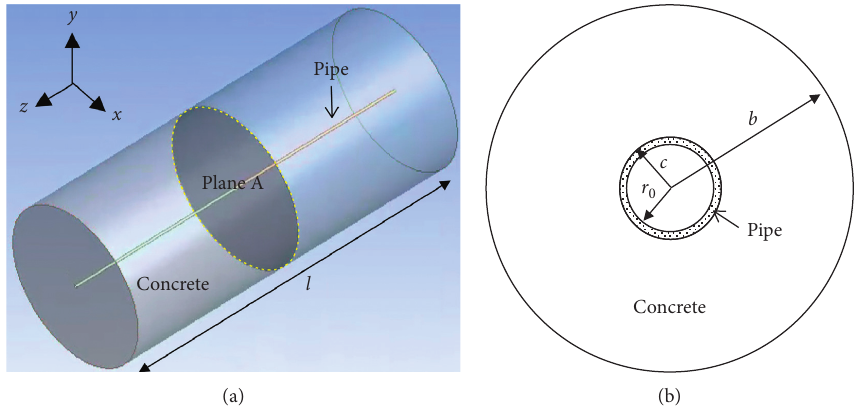
Figure 1: Cylindrical concrete with cooling water pipe: (a) three-dimensional sketch; (b) xy cross section.